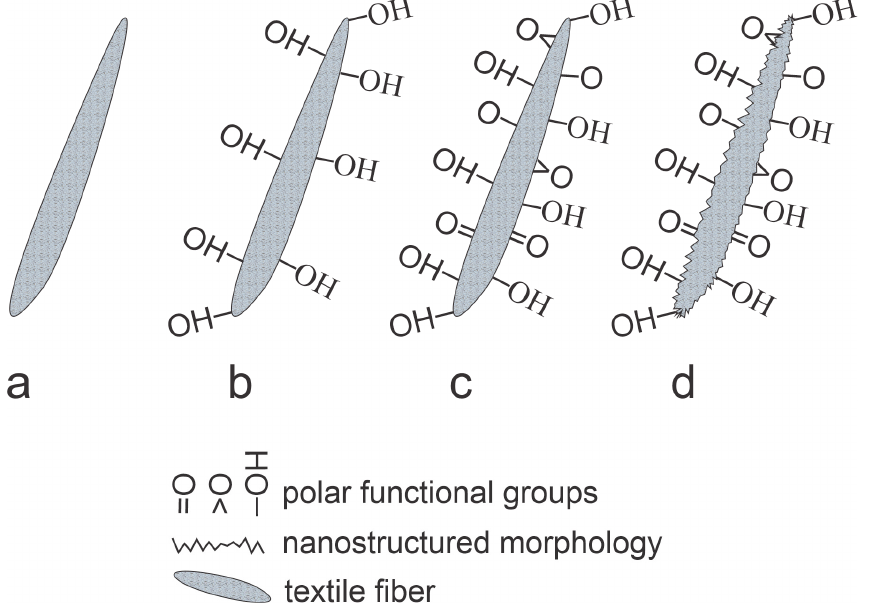
Figure 11. An illustration of a polymer fiber surface finishes upon interacting with neutral oxygen atoms. a —before interaction, b —after receiving the dose of about 10 19 m − 3 , c —after receiving the dose of about 10 22 m − 3 , and d —after very large doses.